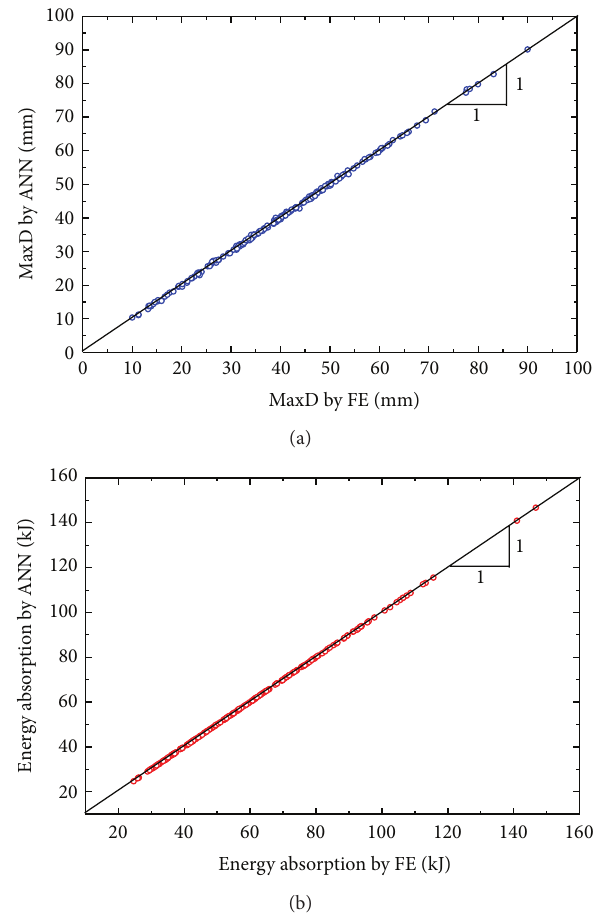
Figure 10: Regression plots of ANN metamodels (a) MaxD of inner face-sheet and (b) energy absorption of